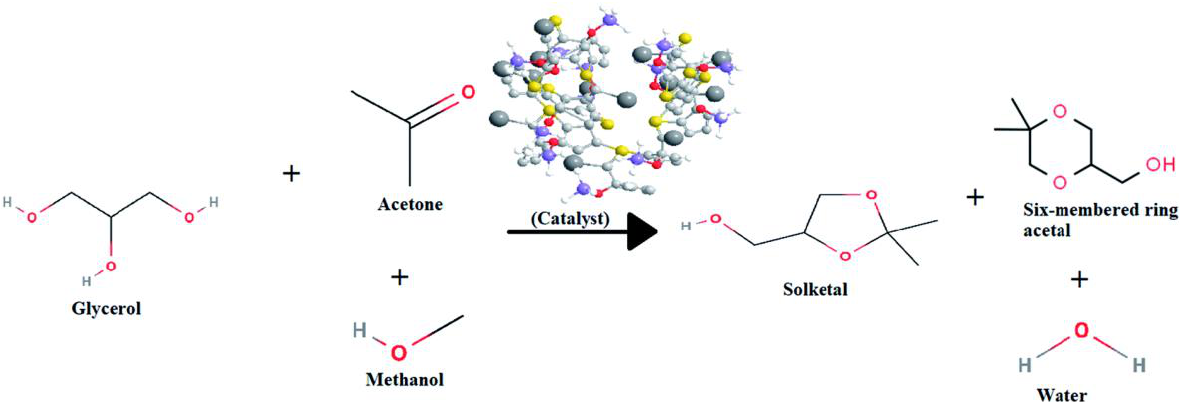
Figure 9. Glycerol ketalization with acetone and excess of methanol [72]. With higher conversion values at approximately 90% (0.6 wt% catalyst, 1:10 glycerol:2- propanone after 2 h), Fabiane and co-workers [73] studied the solvent-free glycerol ketaliza- tion for the production of 2-propane solketal, using amphiphilic carbon catalyst produced by bio-oil sulphonation. The authors state that using this type of catalyst synthesis, amor- phous carbon with high concentration of hydrophilic oxygen and sulfonic surface groups with strong acid sites could be prepared. They also reported that no significant loss in catalytic activity was observed after four consecutive